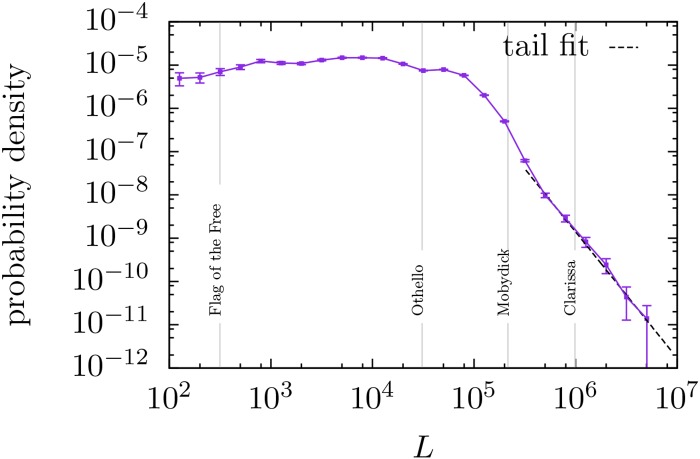
Estimation of the probability density function of text length L in the English Project Gutenberg database, using logarithmic binning (5 bins per decade).Texts with less than 100 tokens are not considered. A power-law fit of the tail [34] yields an exponent 2.92 ± 0.15.